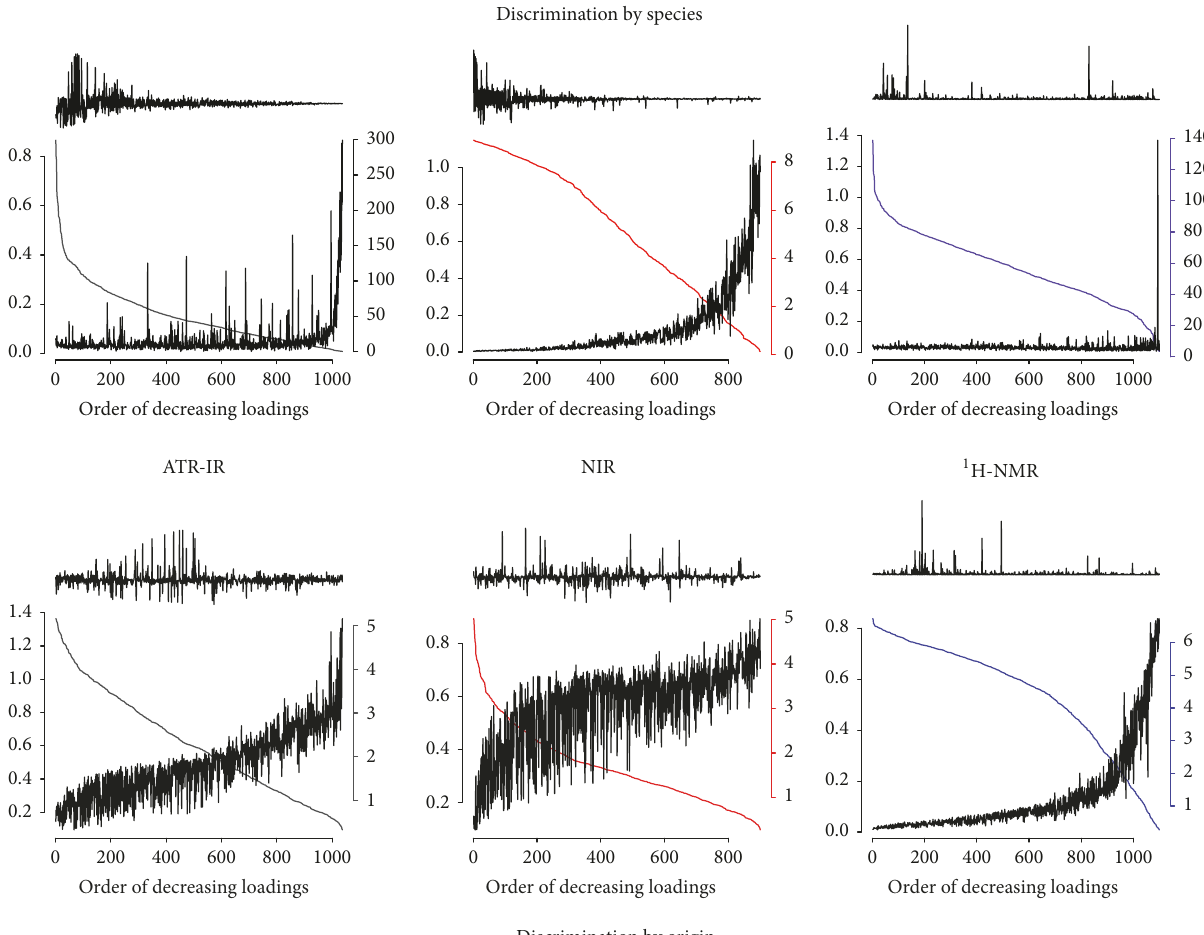
Figure 3: Loadings stability analysis. The first loadings vector was sorted before plotting. The smooth and coloured curve that drops from left to right corresponds to the values of the loadings in decreasing order. The oscillating curve falling from right to left corresponds to the relative error (std. dev./mean) of these loadings. Above each plot, the corresponding preprocessed spectrum prior to scaling, sorted to match the loadings’ order. Results shown were obtained for the 7-fold validation, and results for the Monte Carlo validation are virtually